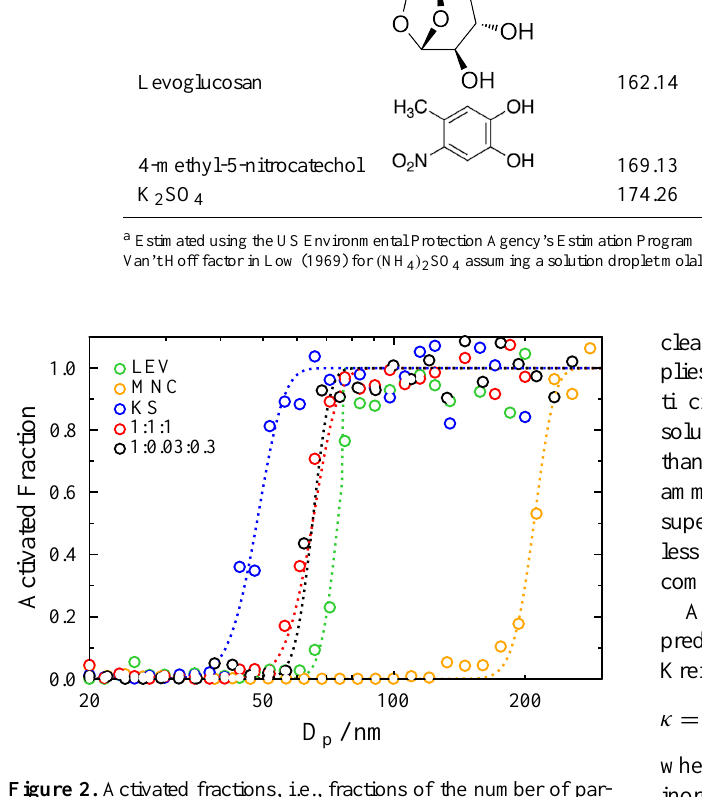
Figure 2. Activated fractions, i.e., fractions of the number of par- ticles at a given particle size activated to CCN as a function of the initial dry particle diameter, for LEV (green), MNC (orange), KS (blue), 1 : 1 : 1 (red) and 1 : 0 . 03 : 0 . 3 (black) particles at S = 0 . 425%. The dotted lines correspond to the fits applying Eq.